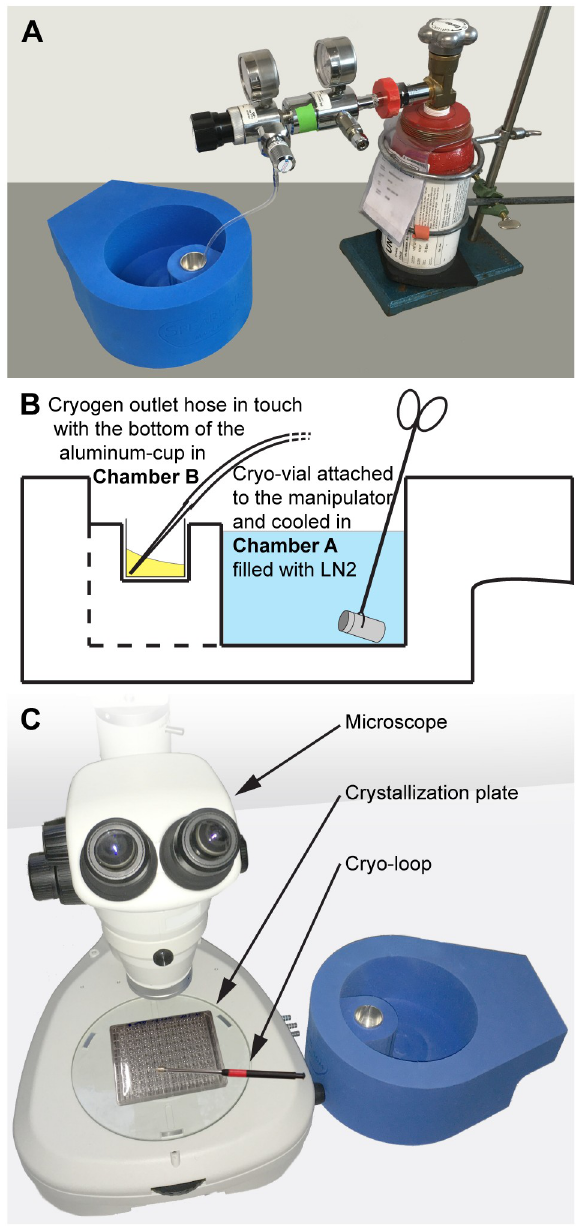
Fig 2. Illustration of the macromolecular flash-cooling procedure. ( A ) Image displaying the cryogen condensation procedure with the double-chambered flash-cooling device placed next to the propane or ethane gas bottle. ( B ) Cartoon describing two different situations, i.e., i). during the cryogen condensation procedure, the gas outlet hose is in contact with the bottom of the aluminum cup in Chamber B (liquid cryogen highlighted in yellow) and ii). after cryogen condensation and prior to crystal harvesting, a cryo-vial is placed into LN2 (highlighted in blue). (C) For crystal harvesting, the device is with its Chamber B positioned as close as possible to the microscope to minimize the distance between crystal harvesting site and Chamber